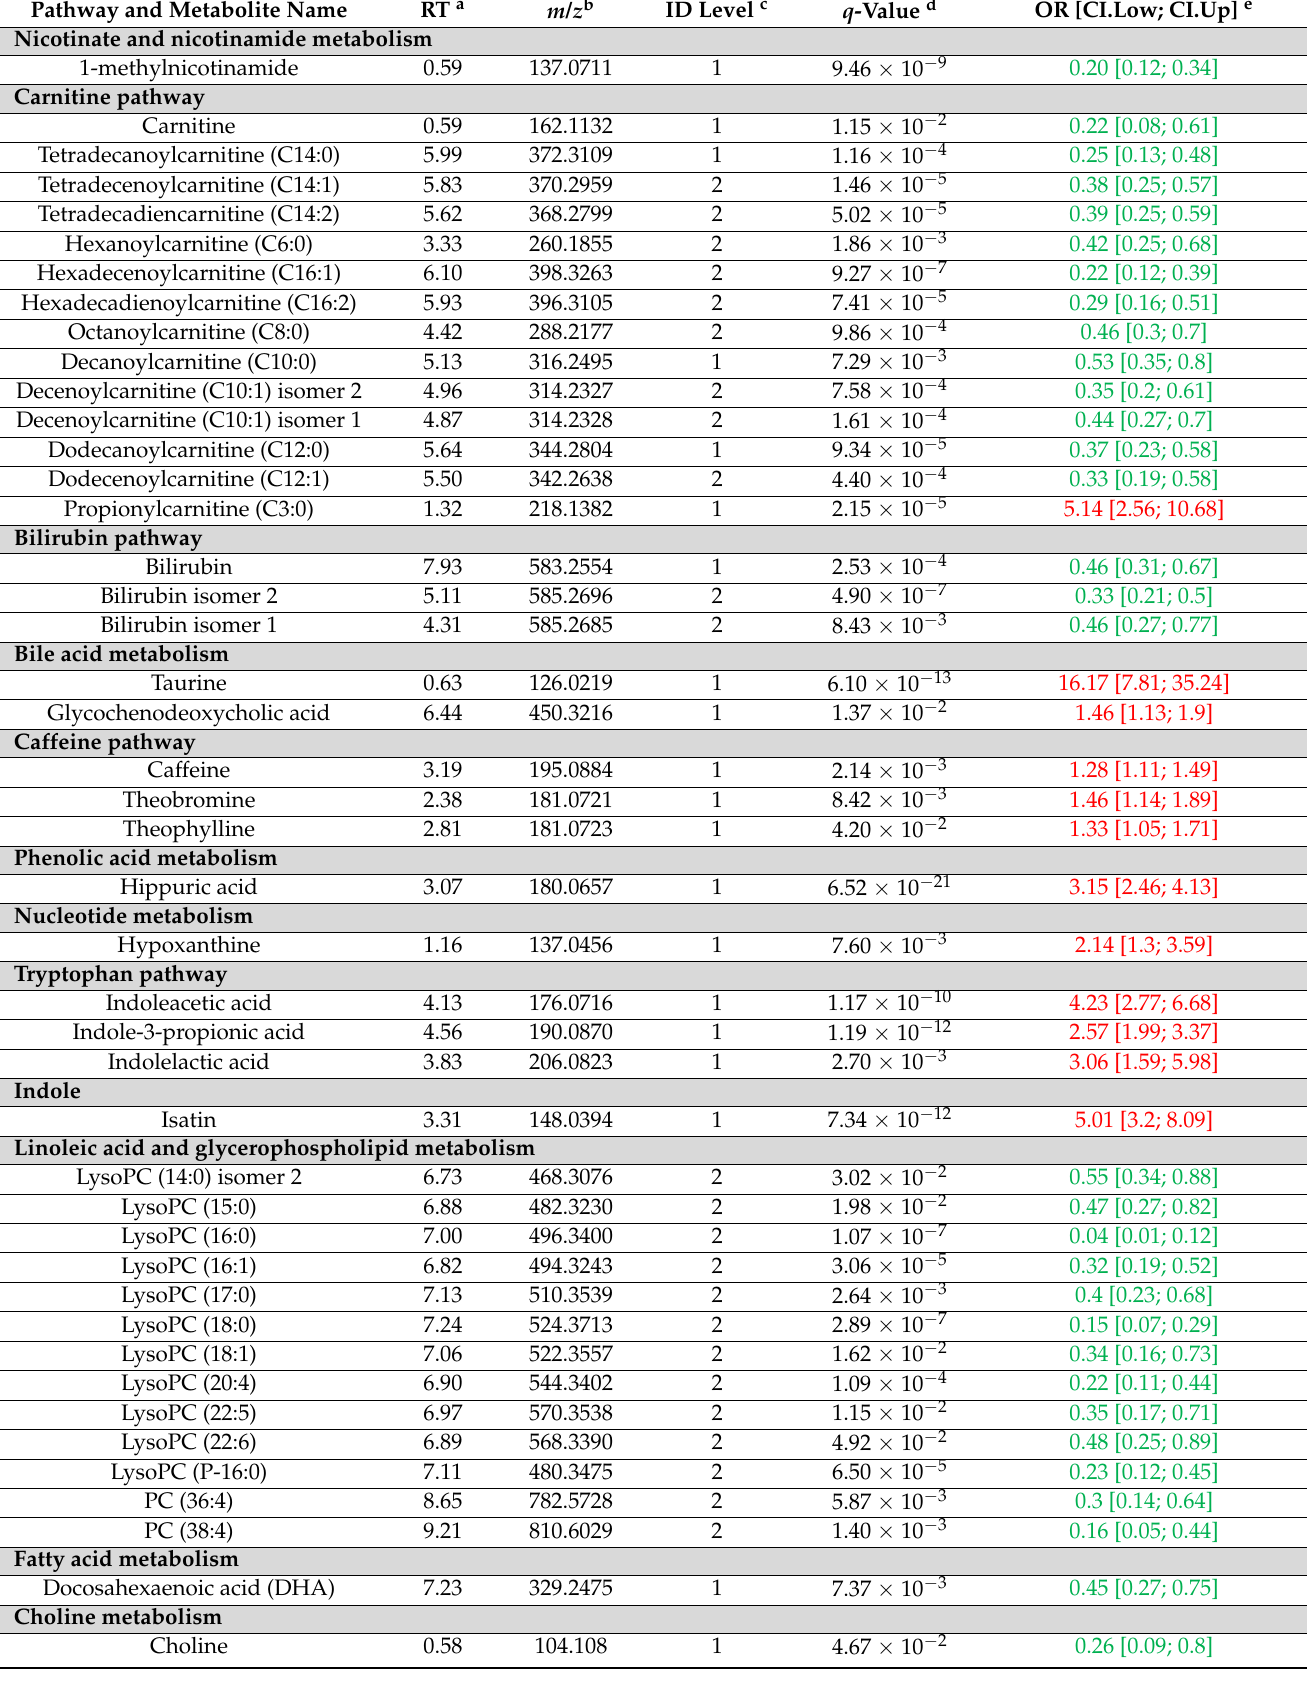
Table 3. List of the identified metabolites and respective pathways when comparing CRC against HR and LR